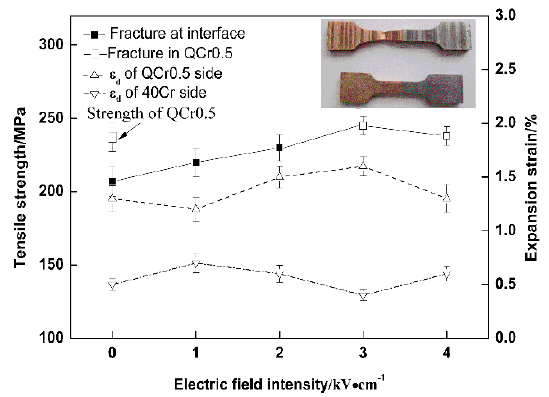
Figure 9. Tensile strength and expansion strain vs. electrical field intensity. ( T = 740 °C, t = 4 min, P 0 = 56.6 MPa, ε 0 = 1.5 × 10 − 4 s − 1 ).